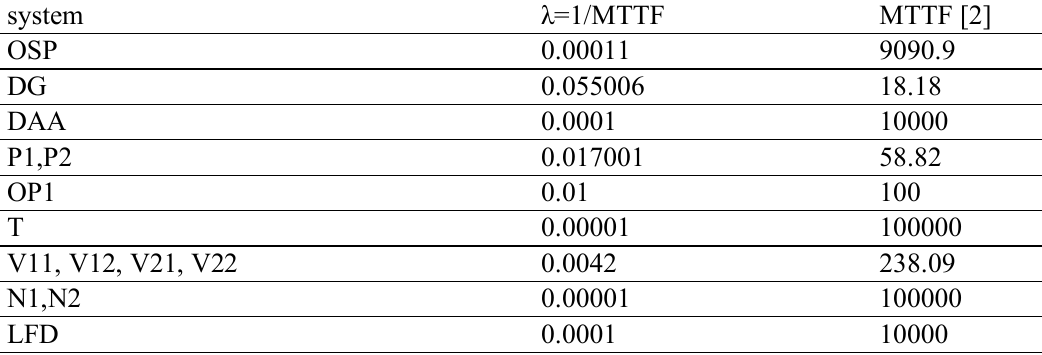
Table 5. Failure rates of the automatic fire sprinkler system